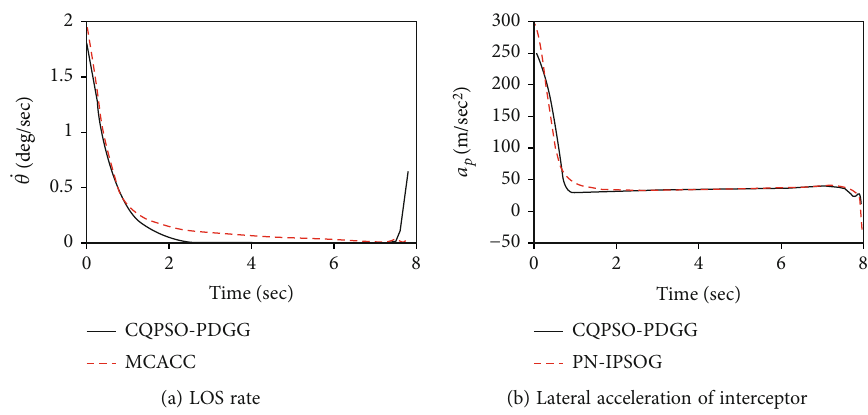
Figure 13: Comparison with MCACC in the presence of step target maneuver. Table 3: Simulation